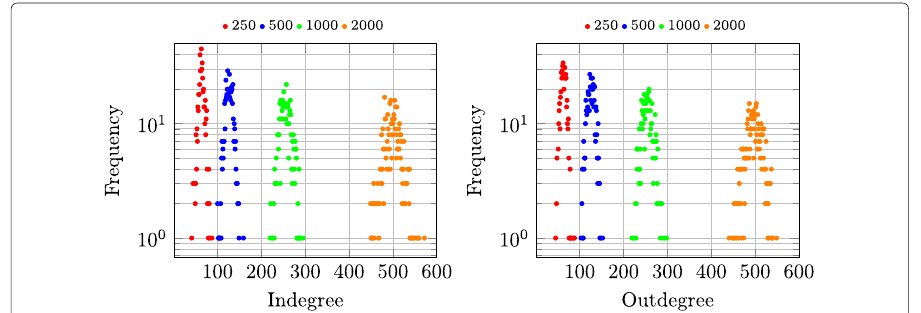
Fig. 3 In-degree and out-degree distributions of nodes of the Erdös Rényi model for directed hypergraphs introduced in Algorithm 1 suggest a normal